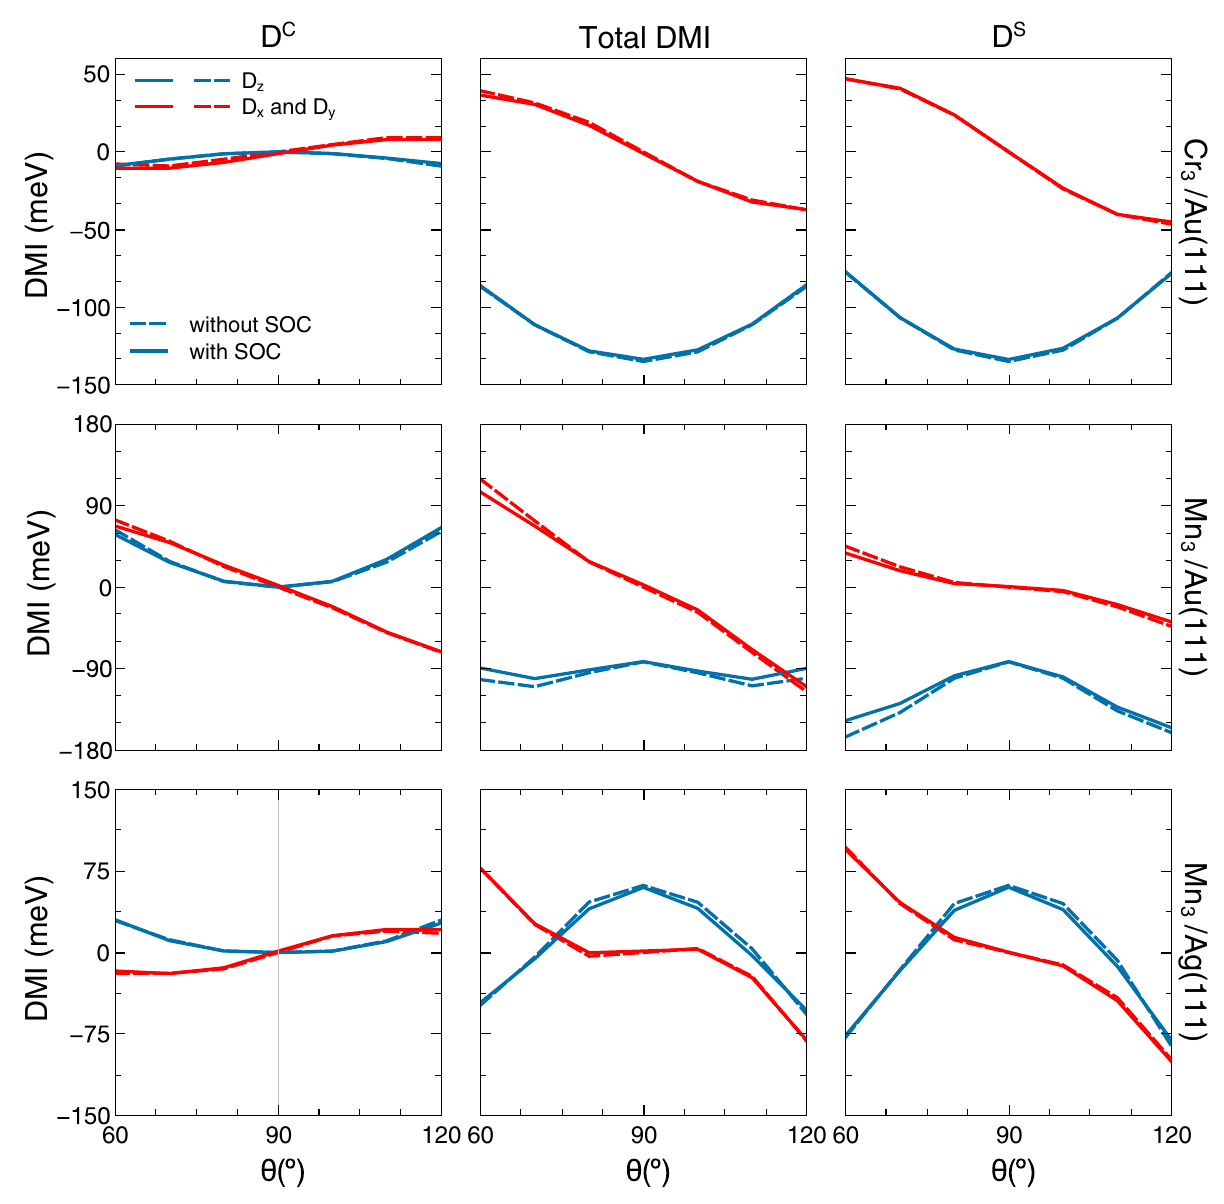
60 ◦ and = / √ 2 . The full line stands for the calculation D y D = = �